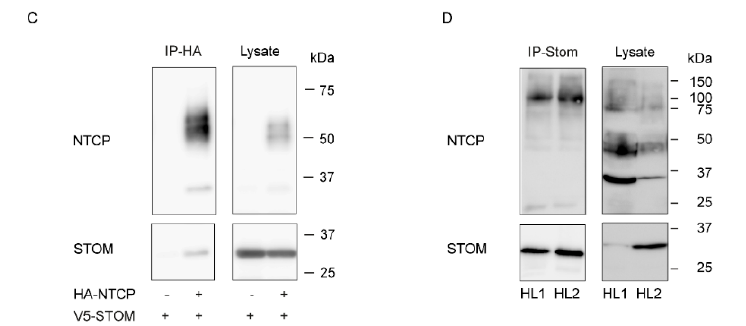
Figure 1. Stomatin and CLCC1 interact with NTCP. ( A ) Scatterplot of median protein intensities of the label-free quantitative mass-spectrometry data, plotting the logarithmic expression in protein levels in the immune-precipitated fraction of NTCP-expressing HepG2 cells versus the expression in parental HepG2 cells. The red dotted line represents a linear model of the intensities of all identified proteins to estimate global protein amount. The green dotted line corresponds to an abundance 16 times higher than in control. N = 4 independent precipitated samples of NTCP-expressing HepG2 and parental HepG2 cells. ( B , C ) Immunoprecipitation of FLAG-hNTCP (B) or HA-hNTCP (C) in U2OS cells expressing tagged hNTCP and / or V5- stomatin (V5-STOM), CLCC1 or a control vector. ( D ) Immunoprecipitation of stomatin in two human liver samples showing co-precipitation of hNTCP. Abbreviations: IP: immunoprecipitated; HL: human